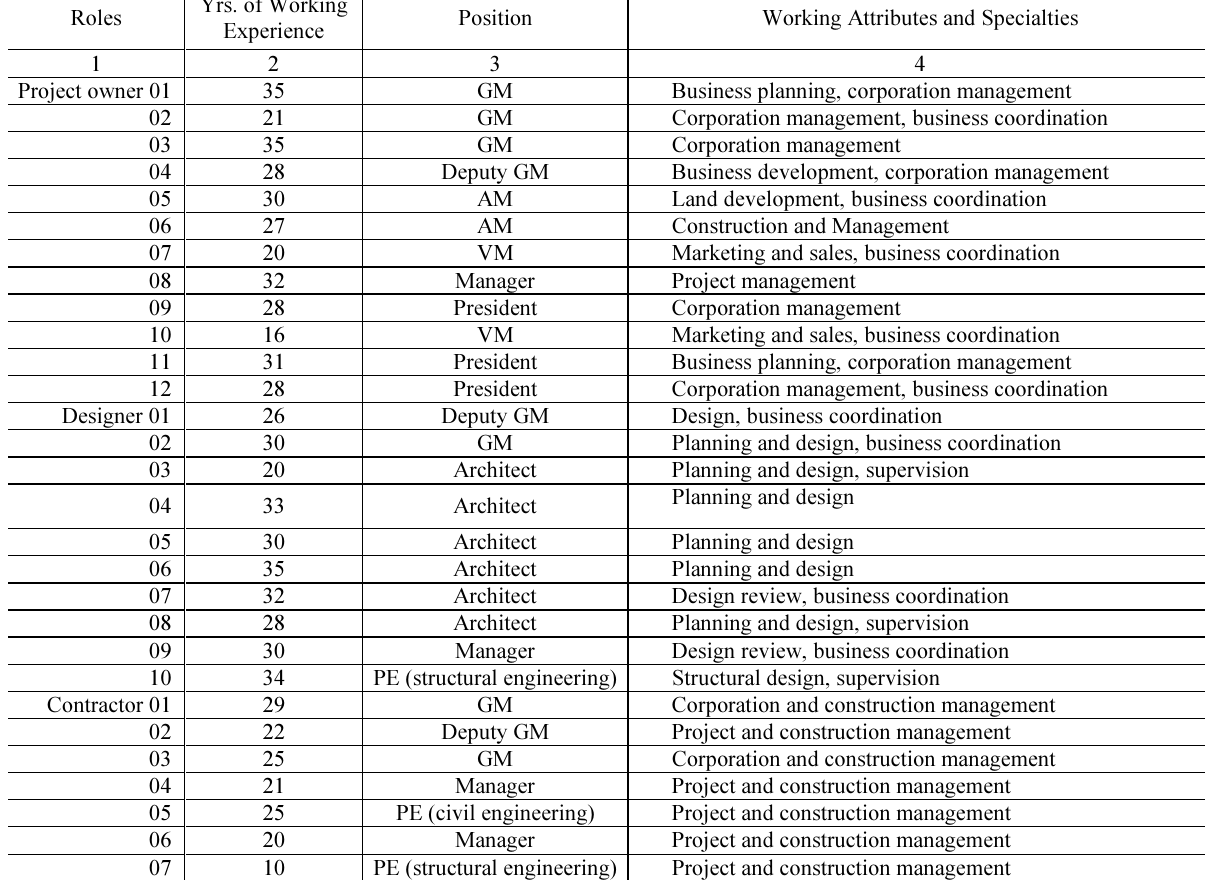
Table 2. Background of the 42 professionals